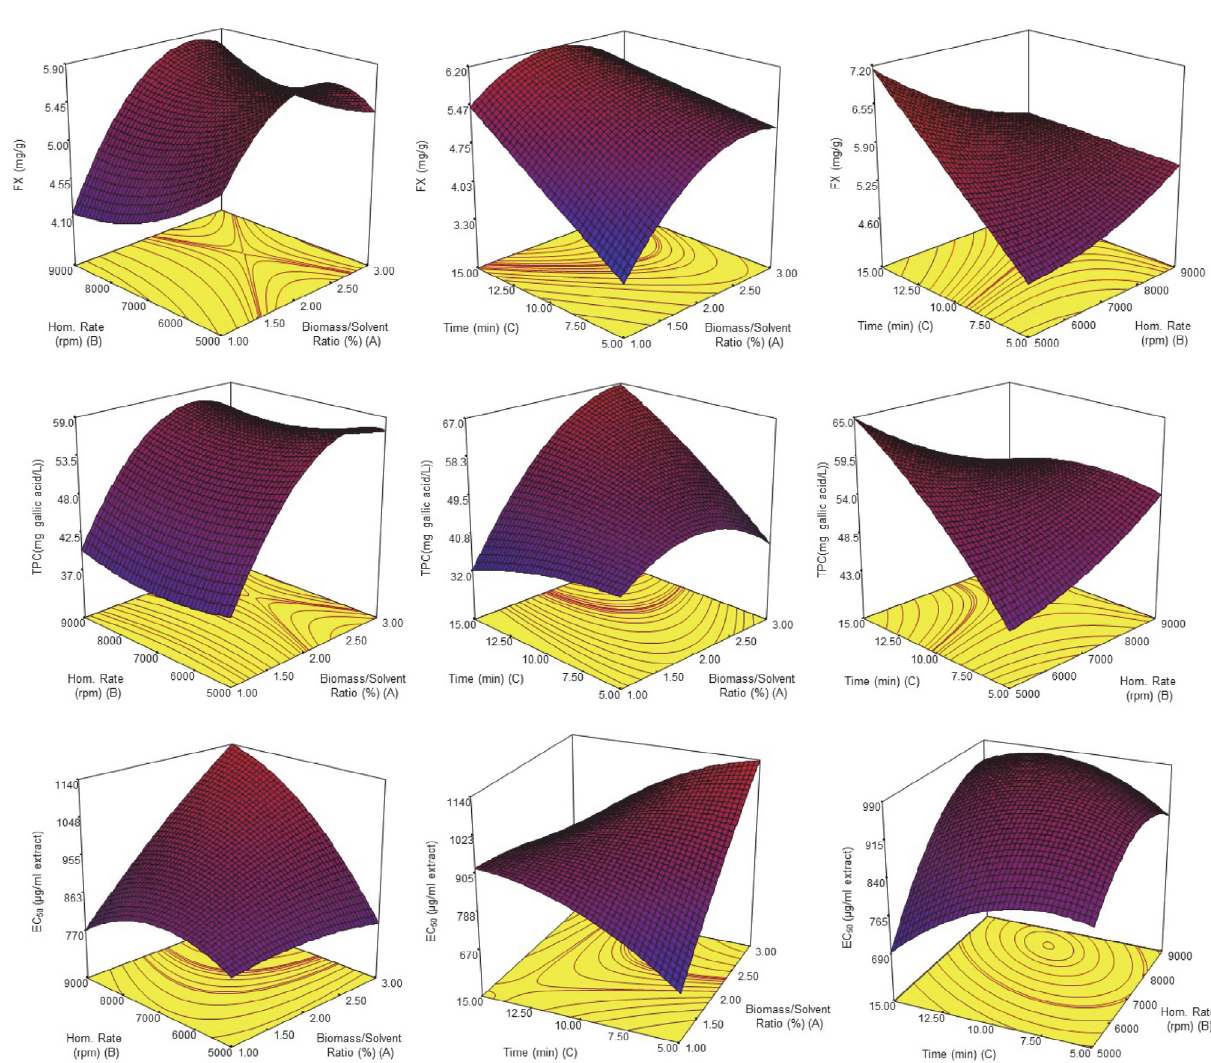
Figure 1. Calculated effects of homogenization extraction process variables on fucoxanthin content (mg/g), total phenolic content (mg gallic acid /L) and antioxidant activity (EC 50 µg/mL